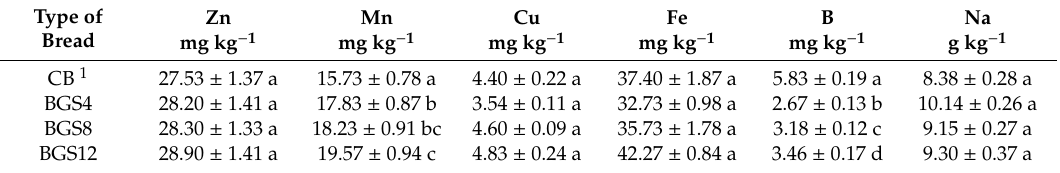
Table 4. The content of selected microelements in control bread and enriched